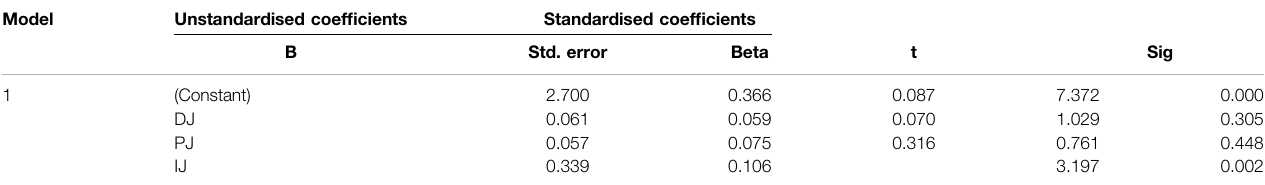
TABLE 4 | Case A: H2. Coef fi cients. Model